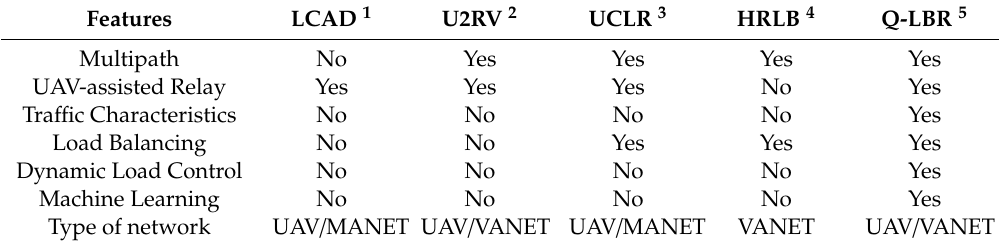
Table 1. Comparative study between routing